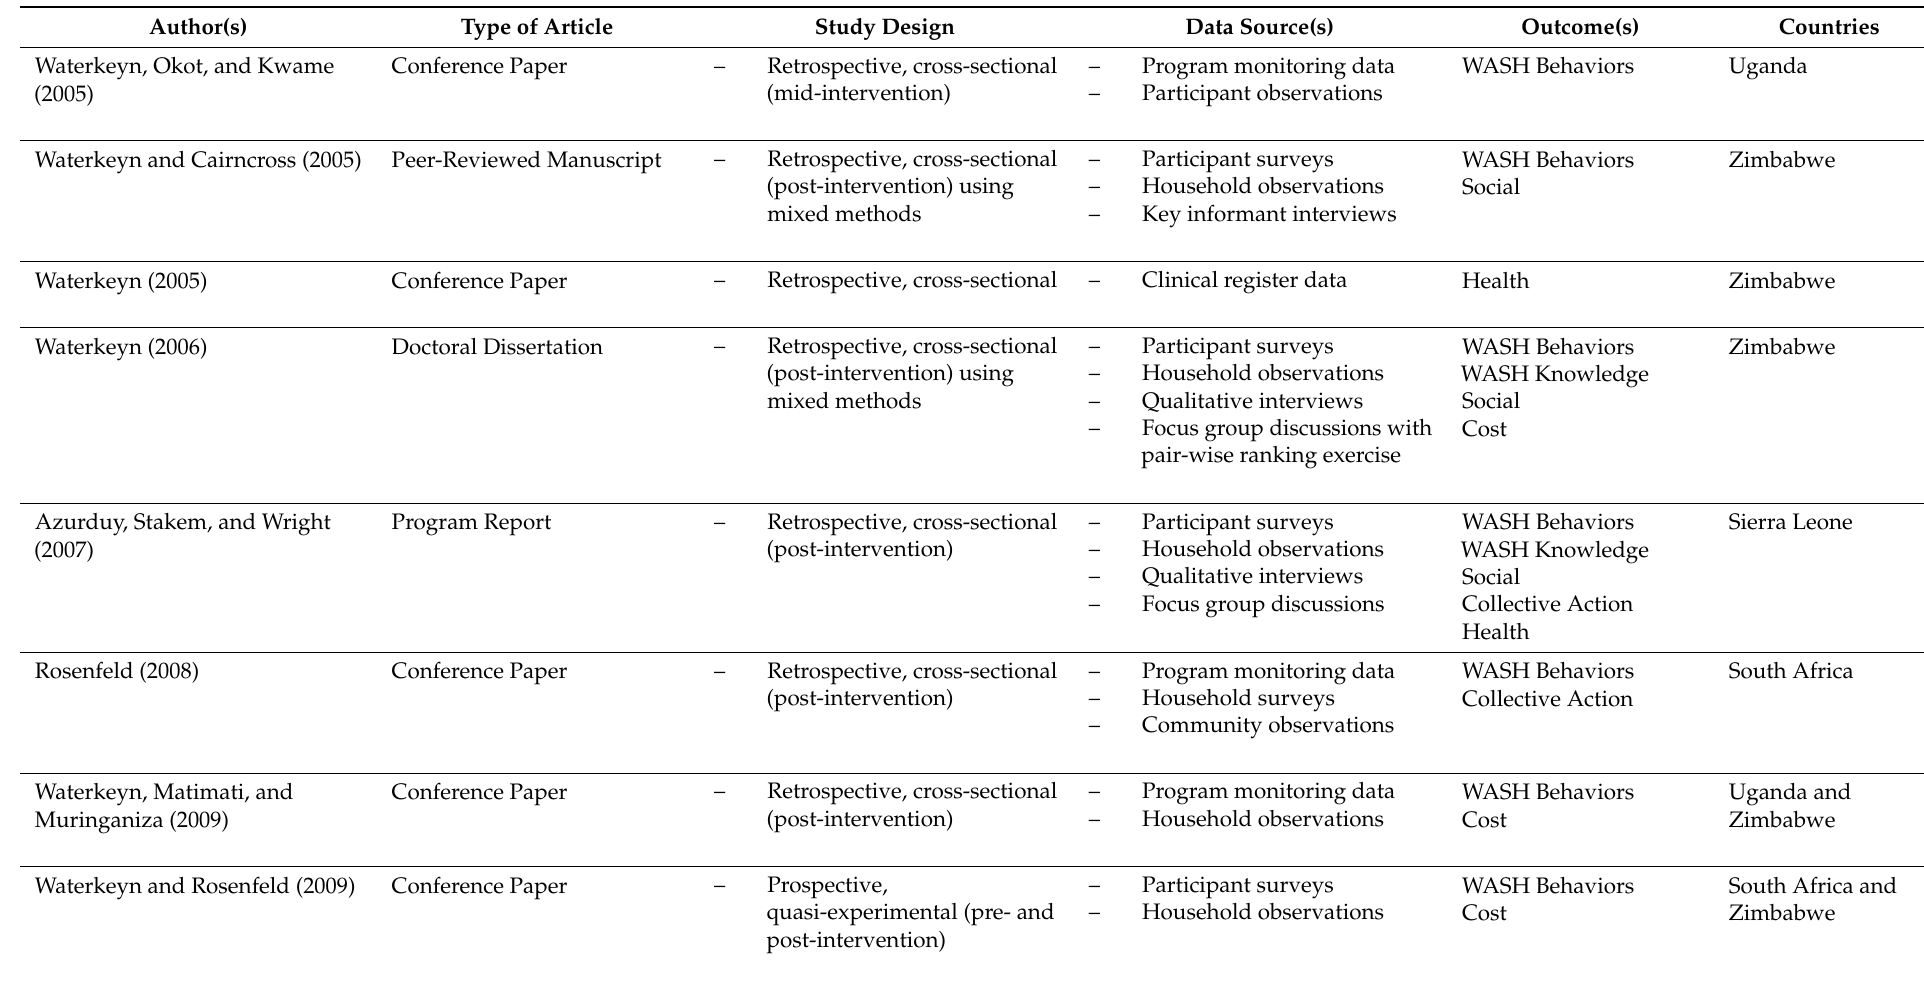
Table 2. Characteristics of reviewed